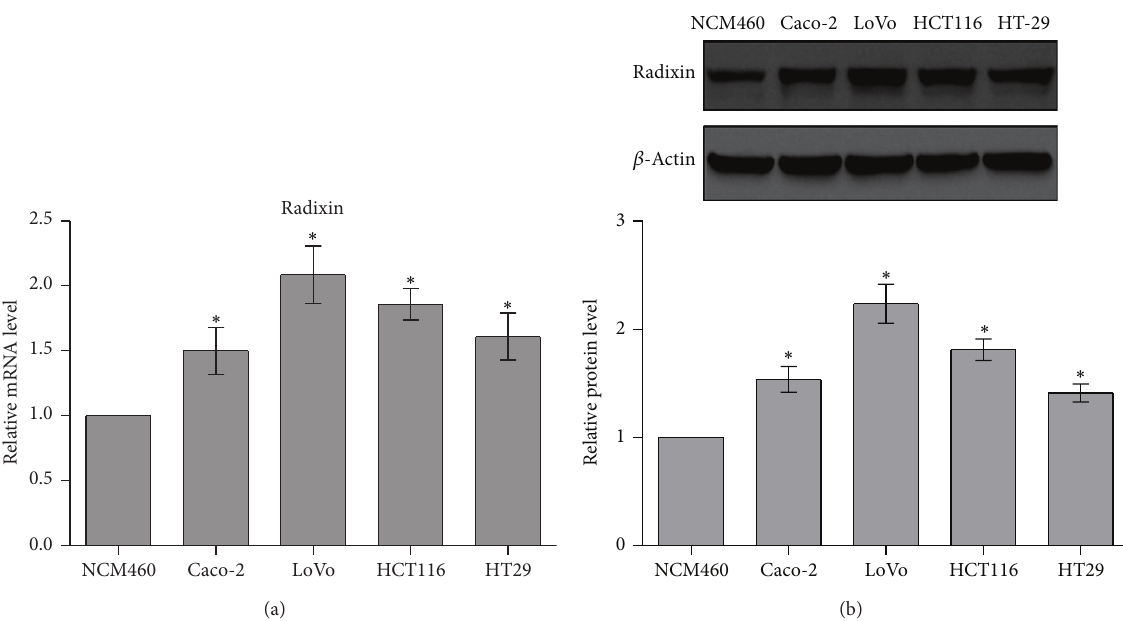
Figure 1: Radixin expression was upregulated in colon cancer cells. (a) Radixin mRNA level in NCM460, HT-29, Caco-2, HCT116, and LoVo cells was determined by real-time PCR. (b) Radixin protein level in NCM460, HT-29, Caco-2, HCT116, and LoVo cells was determined by western blotting. ∗ 𝑃 < 0.05 .